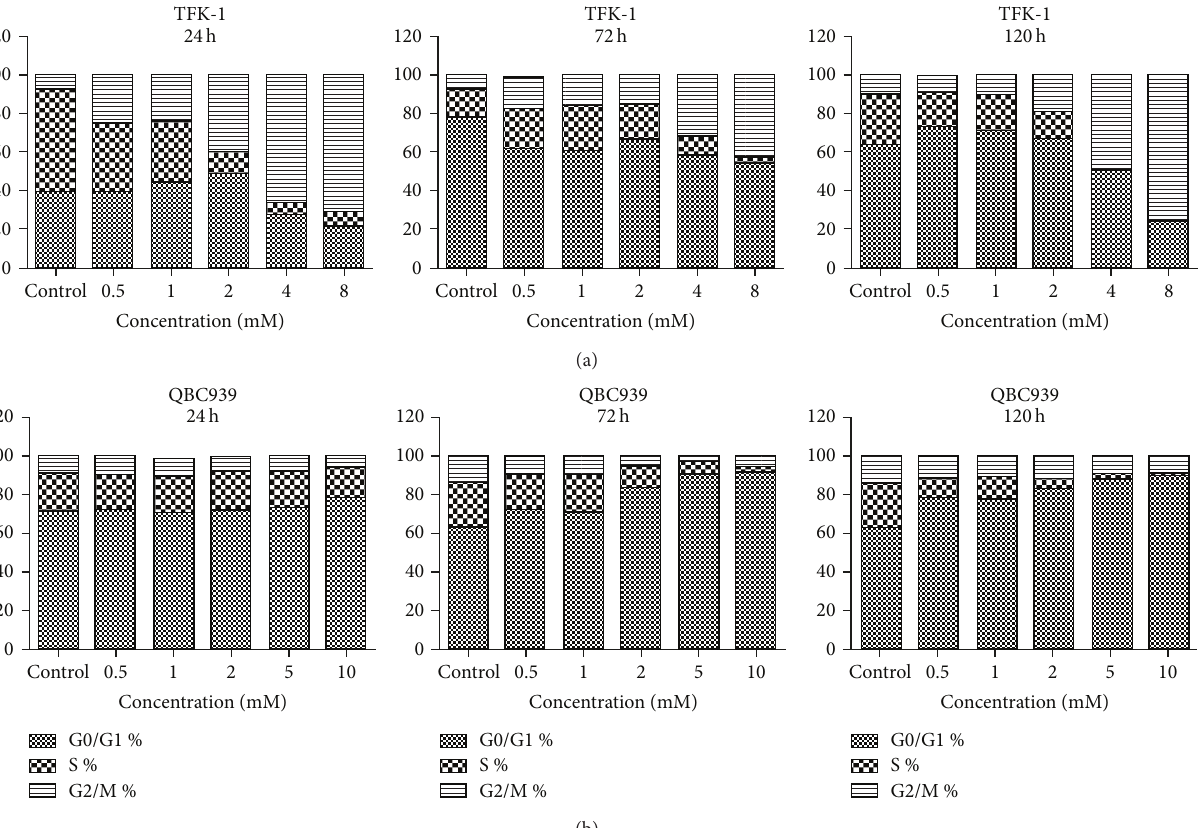
Figure 6: Effects of sodium valproate on cell cycle distribution in cholangiocarcinoma TFK-1 cells and QBC939 cells. (a) TFK-1 cells were incubated with 0–8 mM sodium valproate, and (b) QBC939 cells were incubated with 0–10mM sodium valproate. On 24 h, 72 h, and 120 h, cells were harvested, and the fractions of cells in G0/G1-phase, S-phase, and G2/M-phase were determined by flow cytometry. to 26 puncta (8 mM treated QBC939 cells) (Figures